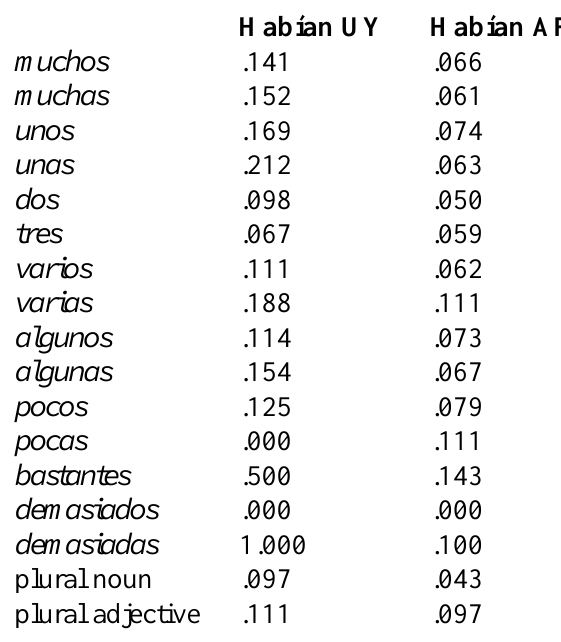
Table 5. Proportion of plural habían before plural